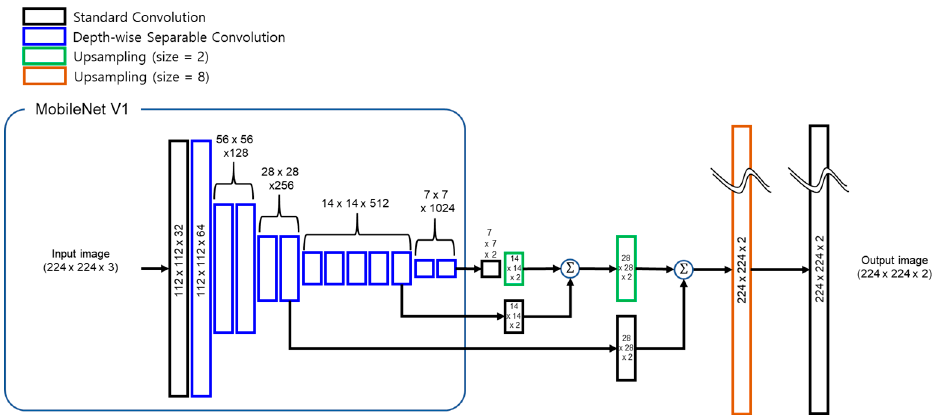
Appl. Sci. 2023 , 13 , 2367 Figure 2. Model architecture of FCN-8s. Figure 2. Model architecture of FCN-8s.